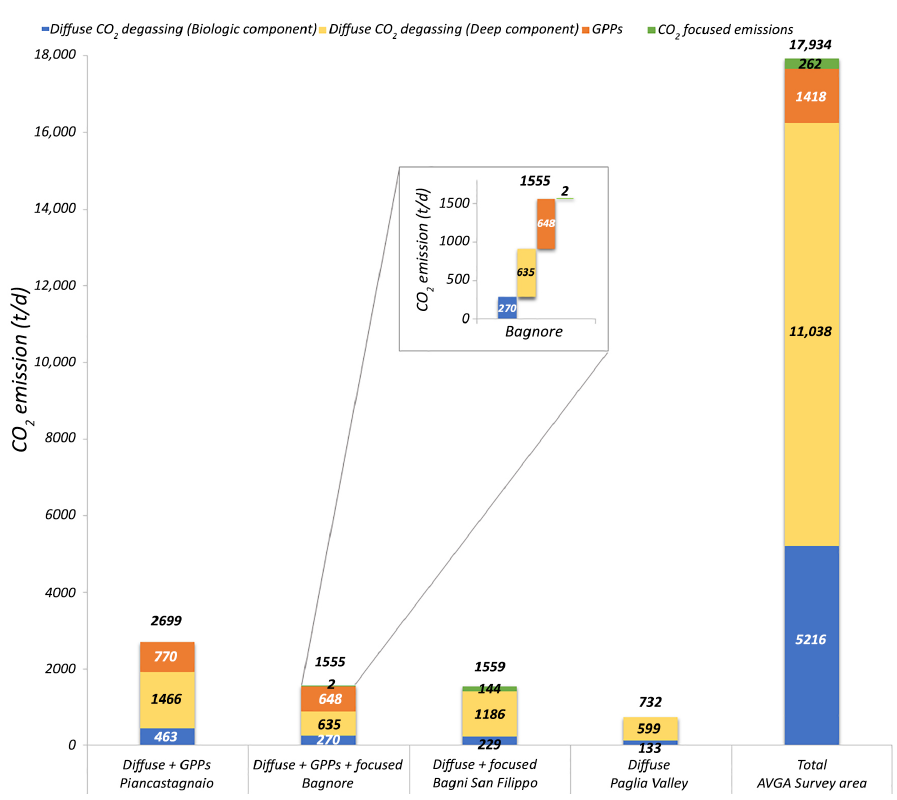
Figure 9. CO 2 emissions in the four high emission areas and in the AVGA area. In the Bagnore and Bagni San Filippo areas, only CO 2 -focused emissions located inside the two identified areas are considered.